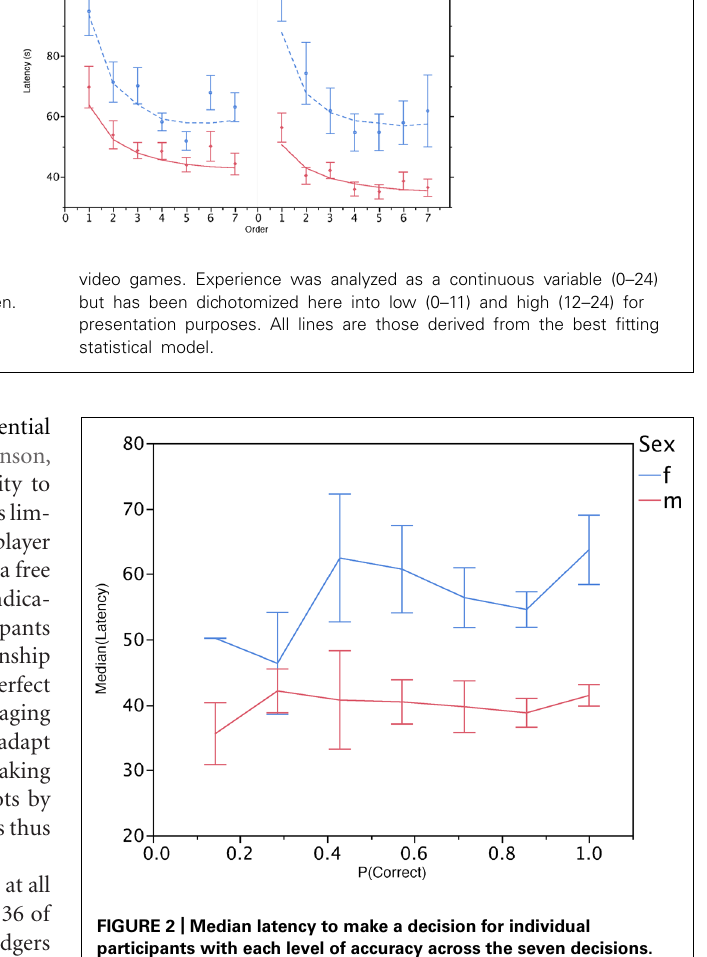
FIGURE 2 | Median latency to make a decision for individual participants with each level of accuracy across the seven decisions.